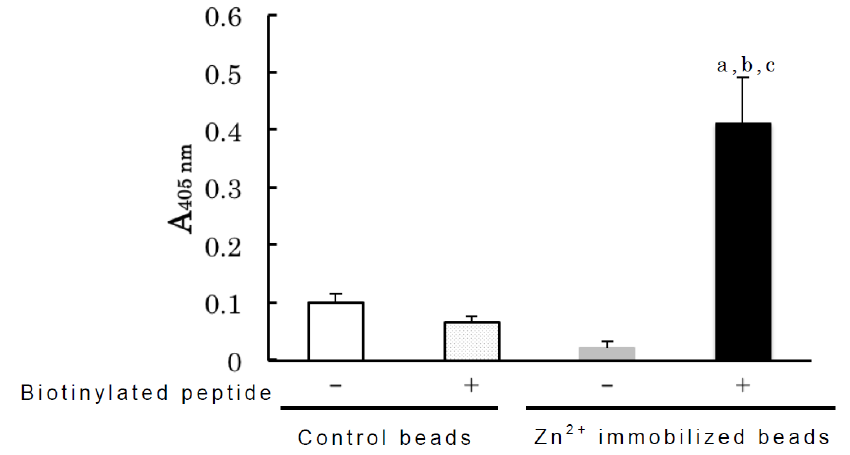
Figure 4. Binding of the zinc-binding protein released from Zn 2+ immobilized beads by canine liver ferritin with biotinylated peptide (DPHLCDF). After removing serum components from human serum with non-specifically binding control beads (Sepharose 4B) as described in “Experimental Section”, zinc ion immobilized on beads (20 µL) was added to the human serum samples followed by the addition of canine liver ferritin (5